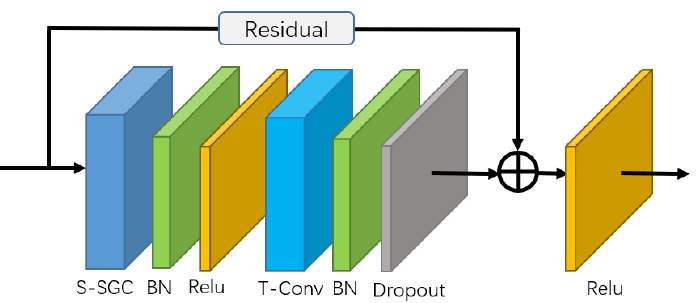
Figure 3. Illustration of basic graph convolutional block. The residual connection is applied to guarantee the stability of training. S-SGC represents the self-attention enhanced spatial graph convolutional layer. T-Conv represents the temporal convolutional layer.